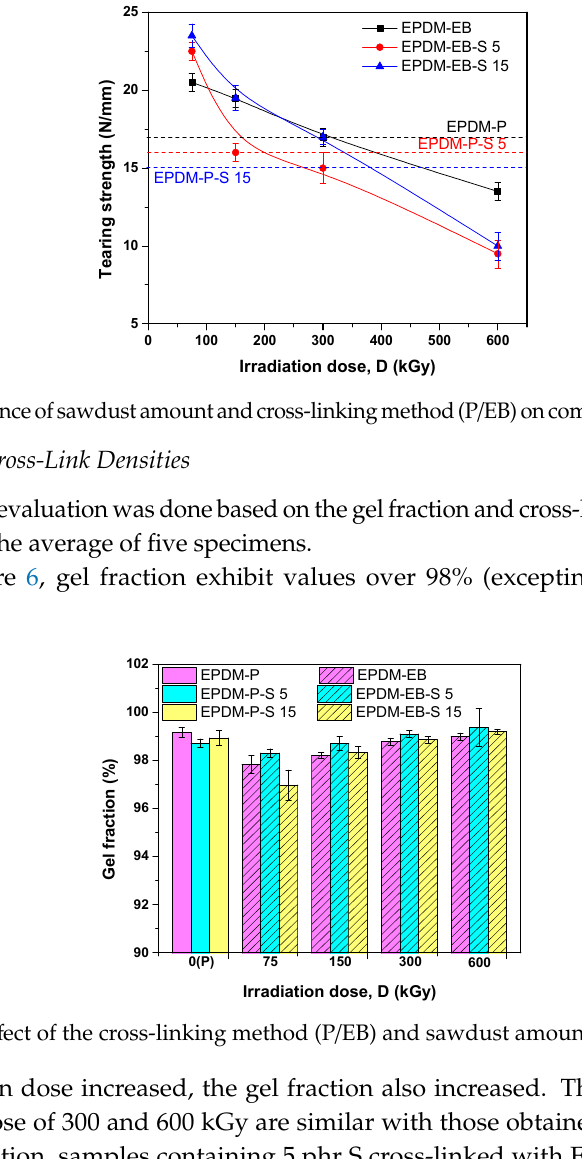
Figure 5. The influence of sawdust amount and cross-linking method (P/EB) on composites tearing strength.